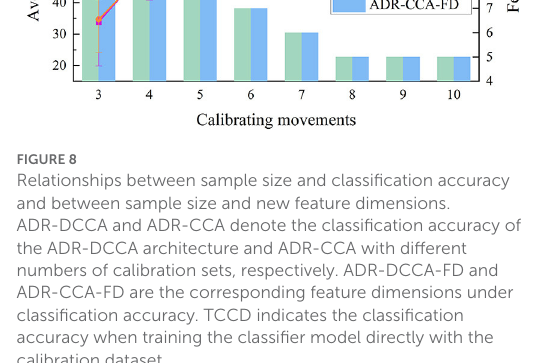
for the rehabilitation of muscle-deficient patients and motion recognition of missing channel users. Finally, we tested the proposed method in the rehabilitation laboratory, and the accuracy of action recognition reached 90.52%. In conclusion, our proposed ADR-DCCA method has important potential applications in the field of